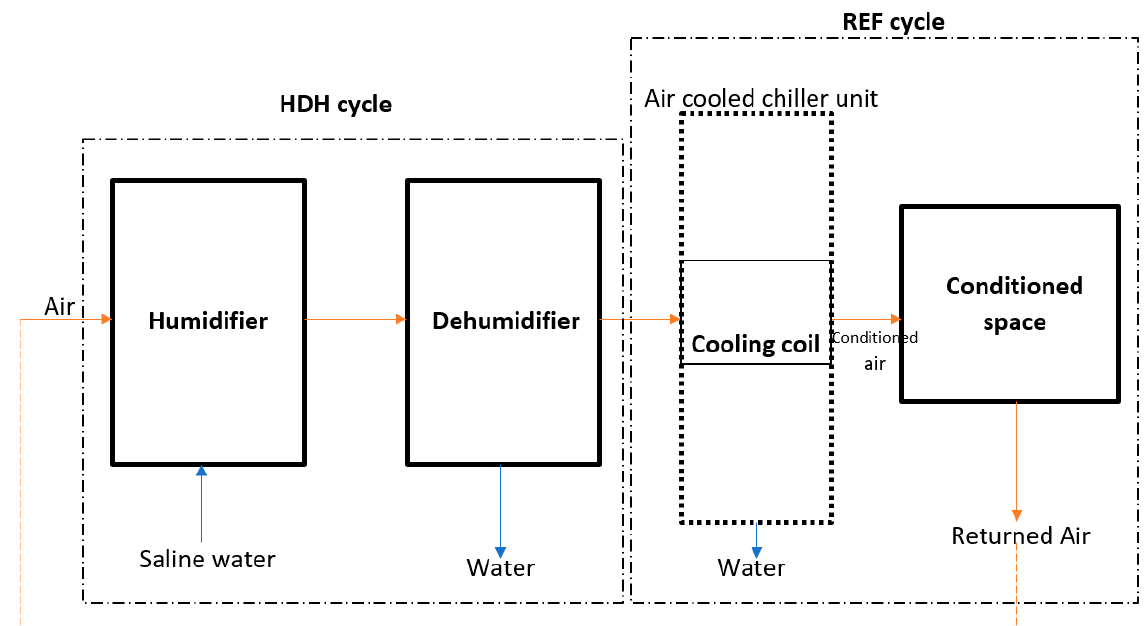
Figure 5. Simple HDH–REF cycle.